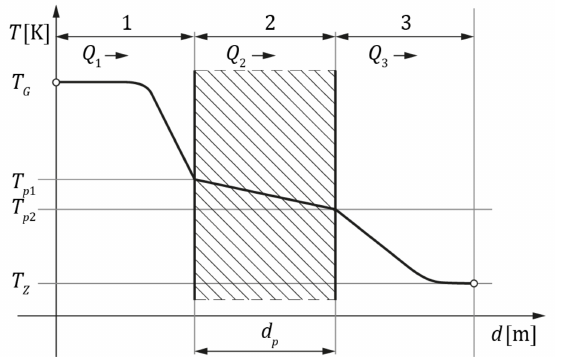
Figure 5. Temperature drop from hot fluid, through the barrier, to cold fluid [37], where d is the path of heat transport / distance from the pipeline axis, d p is the barrier thickness / pipe wall thickness, T G is the temperature of hot fluid (flowing in the pipeline) in the observation plane, T Z is the temperature of cold fluid (flowing on pipeline outside surface) in the observation plane, T 1 and T 2 are temperatures at fluid–solid interface corresponding to the T p 1 and T p 2 temperatures at the internal and external surfaces of the barrier (pipeline wall), 1 and 3 indicate convection and 2 indicates heat